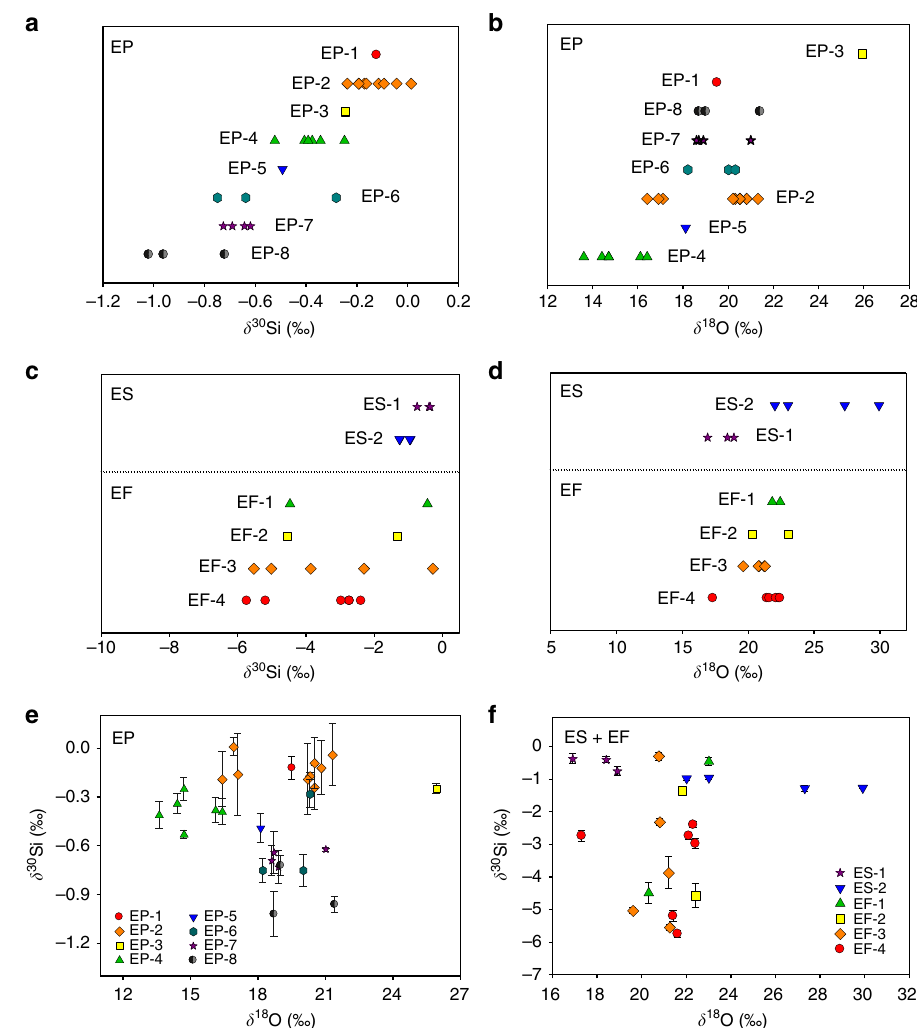
Fig. 4 Si and O isotopic fi ngerprints of engineered SiO 2 NPs synthesized by different methods and from different manufacturers. a , b Si ( a ) and O ( b ) isotopic compositions of precipitated SiO 2 NPs (EP) grouped according to manufacturers. c , d Si ( c ) and O ( d ) isotopic compositions of sol – gel and fumed SiO 2 NPs (ES and EF) grouped according to manufacturers. e Si-O 2D isotopic fi ngerprints of EP. f Si-O 2D isotopic fi ngerprints of ES and EF. The error bars in e and f represent 2s.d. in parallel measurements ( n = 2 –